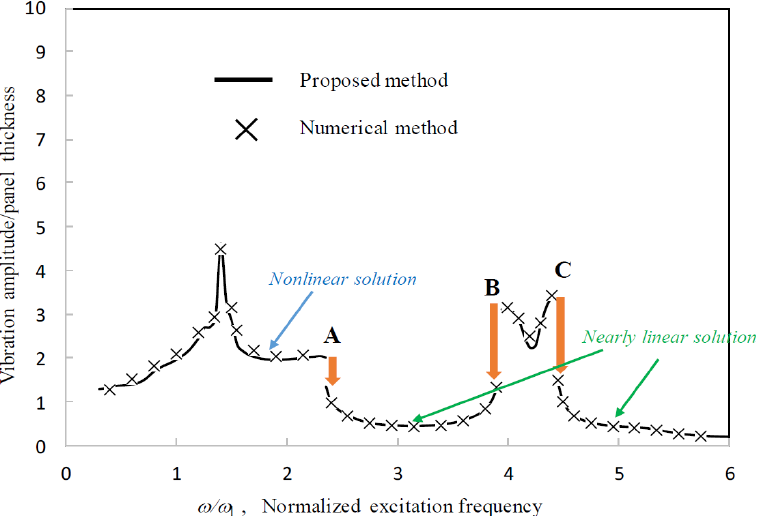
Figure 5. Comparison between the solutions obtained from the proposed method and numerical integration method [6] (number of structural modes = 2, number of acoustic modes = 4, l = 5 a , γ = 2, θ = 0; the orange arrows represent the “jump phenomenon”; “ A ”, “ B ”, and “ C ” represent the particular points on the solution curve).